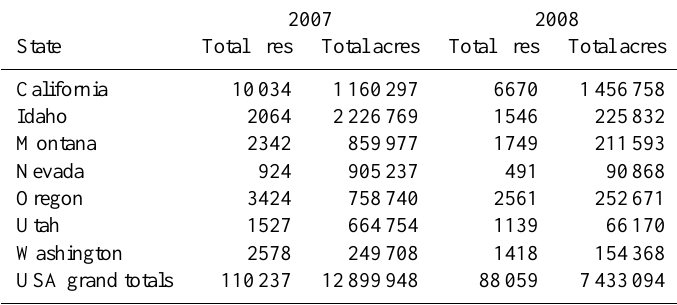
Table 1. Total annual fires and acres burned by